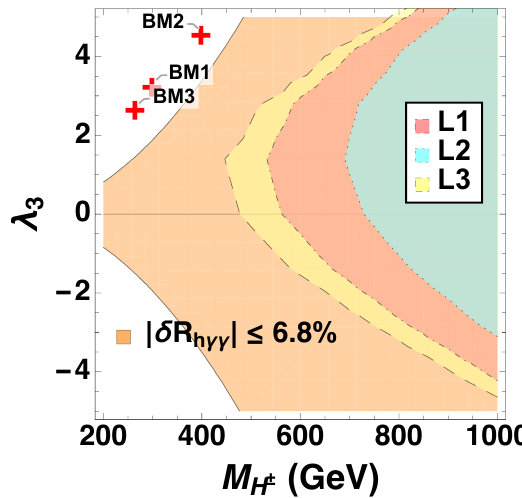
) plane for | δσ 0 . 5% (red, cyan and yellow areas outlined Figure 7. Contours in ( λ 3 , M Zh | ≤ H ± with dotdashed, dotted and dashed lines and labelled with L1, L2 and L3) and | δR 6 . 8% hγγ | ≤ (orange area outlined with solid lines). L1, L2 and L3 respectively denote the choice of λ and λ 4 5 in accordance with that in BM1, BM2 and BM3, which are listed in table 2. The three benchmark points BM1, BM2 and BM3 are marked with red